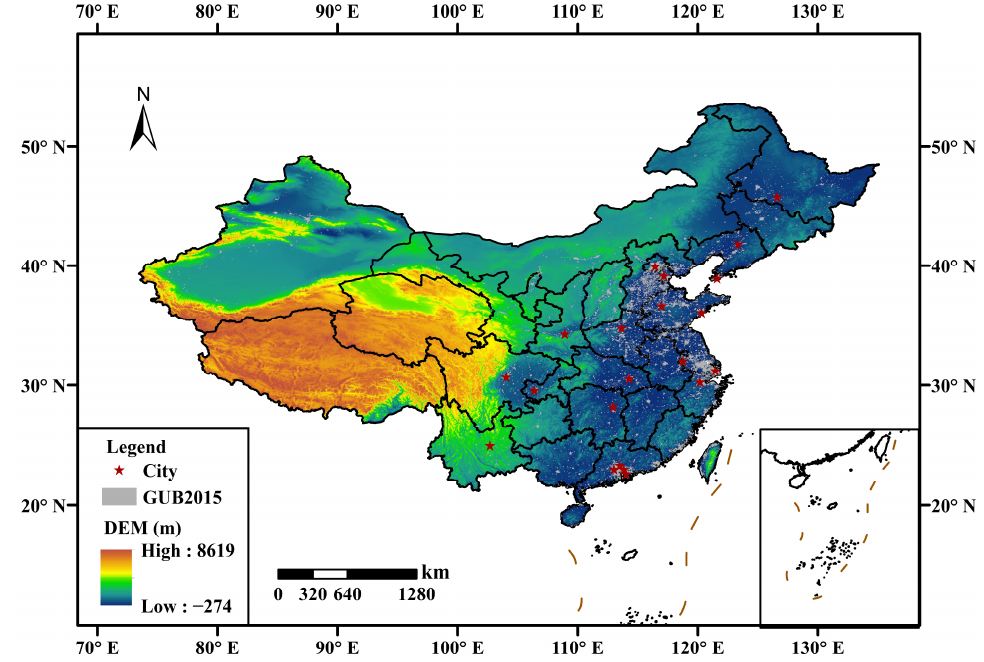
Figure 1. Locations of the 21 major cities in China and urban boundaries for